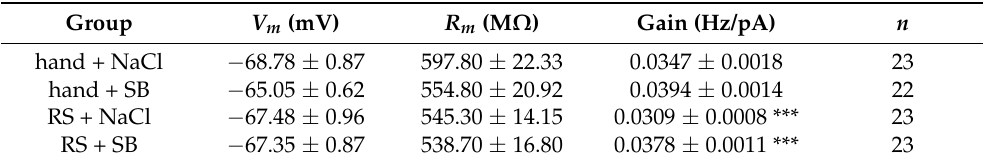
Table 4. Effects of restraint and SB 269970 on basic electrophysiological characteristics of DRN neurons (mean ±